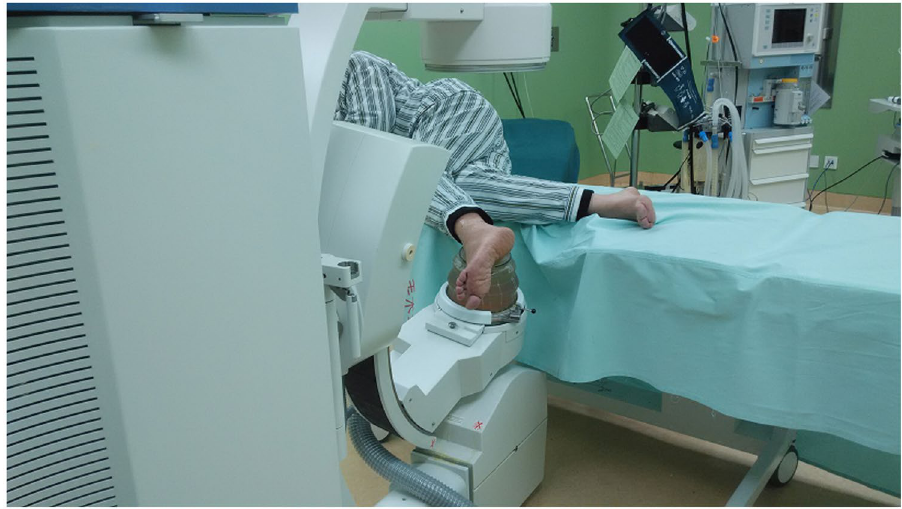
Figure 4. Image showing shockwave treatment of OCLs of the talus (Dornier Compact DELTA II, Munich, Germany). Note: The patient consented to publish the specific